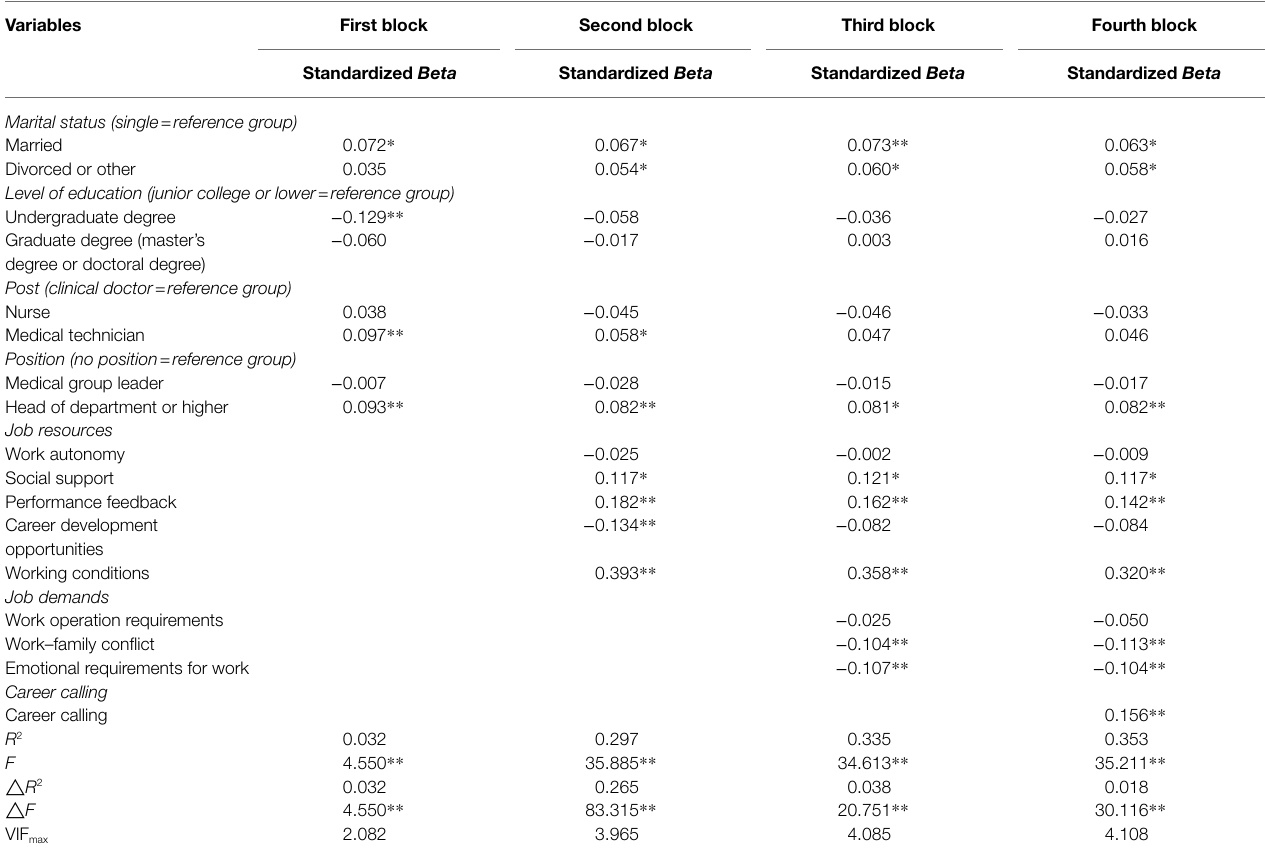
TABLE 5 | Hierarchical multiple regression analysis of job satisfaction.